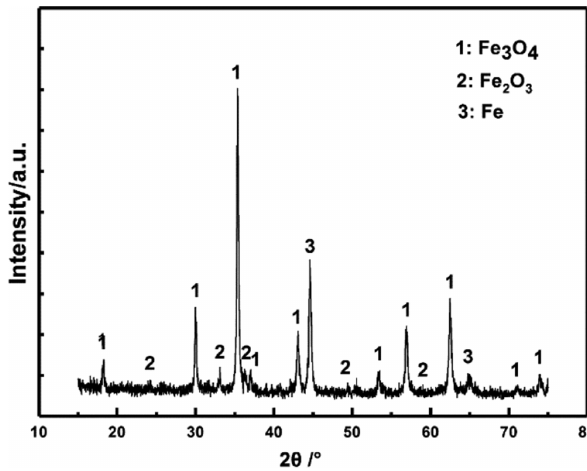
Figure 3: XRD result of the corrosion section of the tube3.3 Analysis of water and coal quality.